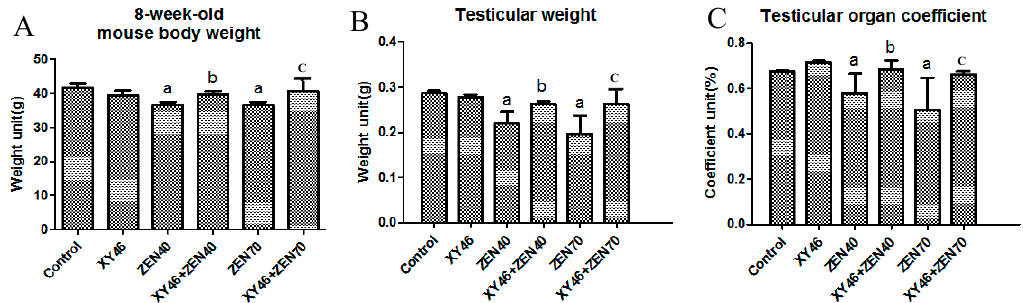
Figure 3. Mouse physiology and reproductive organ indices, showing: ( A ) mouse body weights after 8 weeks, ( B ) mouse testicular weights after 8 weeks, and ( C ) the corresponding mouse reproductive organ coefficients. Key: “a”—result is significantly different compared to the control group ( p < 0.05), “b”—xy46 + ZEA40 is significantly different from the ZEA40 result ( p < 0.05), and “c”—xy46 + ZEA70 result is significantly different from the ZEA70 result ( p < 0.05). Seven mice were randomly selected from each group for testing.